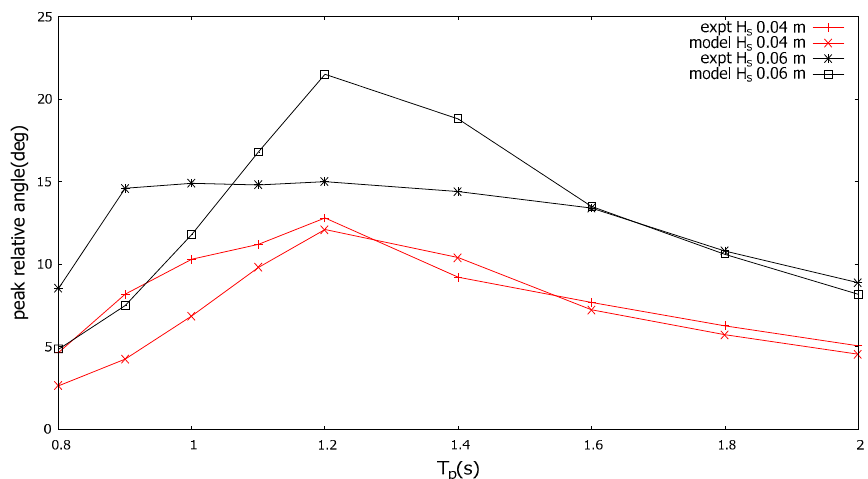
Figure 9. Variation of peak relative angle θ r with T p for H s ≈ 0.04 m and 0.06 m from experiment and linear diffraction/radiation model with measured mean force.